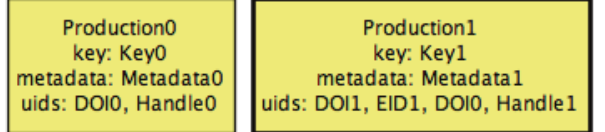
Figure 6. PTCRIS profile after user